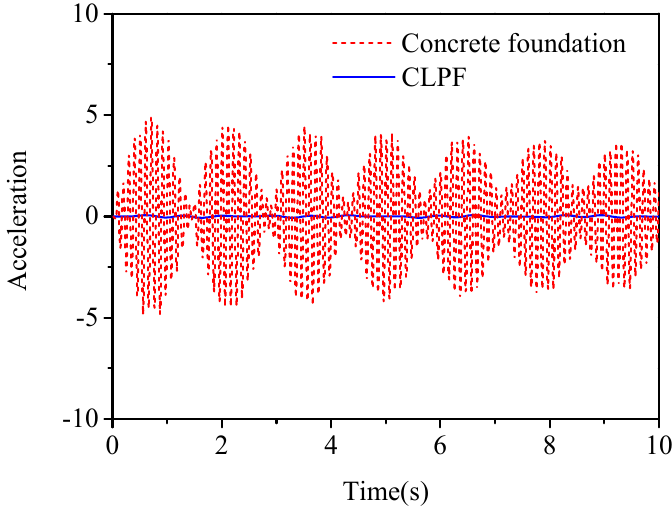
Figure 15. Acceleration responses of node P under harmonic excitation with frequency f = 10 Hz.